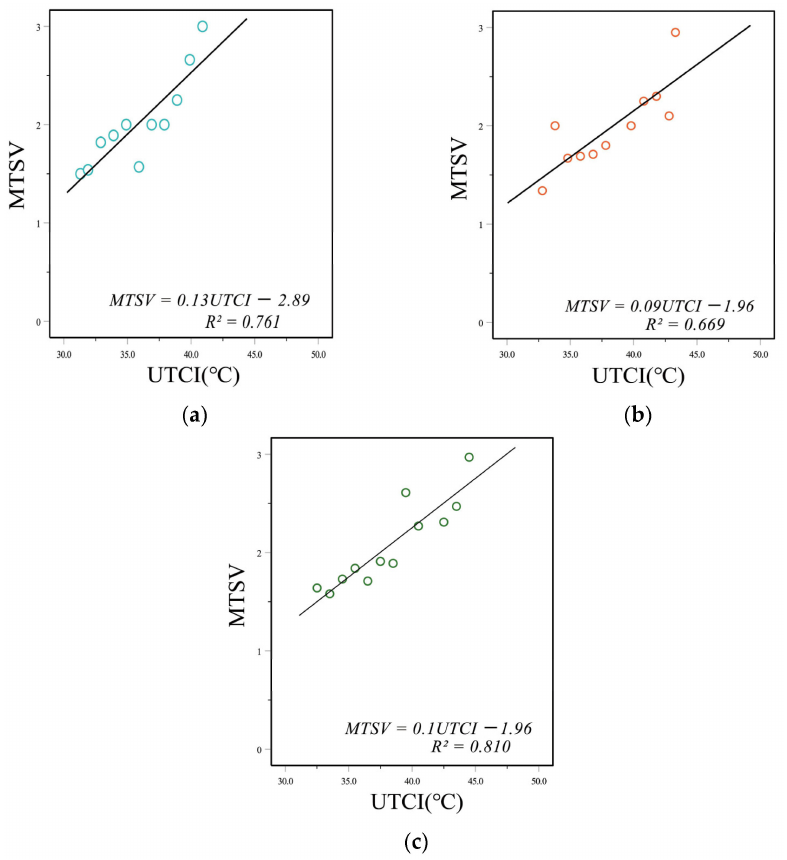
Figure 9. Correlation between UTCI and MTSV: male ( a ), female ( b ) and all respondents ( c ). Neutral temperature refers to the temperature at which people feel neither hot nor cold [38]. When MTVS = 0, the corresponding UTCI is the group’s neutral UTCI (NUTCI). Substituting MTSV = 0 into the equation separately, the NUTCI was calculated to be 22.2 ◦ C for males, 21.8 ◦ C for females, and 19.6 ◦ C for all child respondents. The closing results showed a slight gender difference. The neutral temperature range (NUTCIR) refers to the range in which the neutral UTCI is determined when the MTSV is between − 0.5 and 0.5 (both − 0.5 and 0.5). Based on the linear regression equation, the NUTCIR can